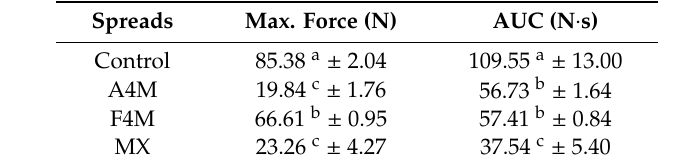
Table 1. Textural parameters (mean ± standard deviation) from penetration curves of the different spreads at 20 °C . Spreads